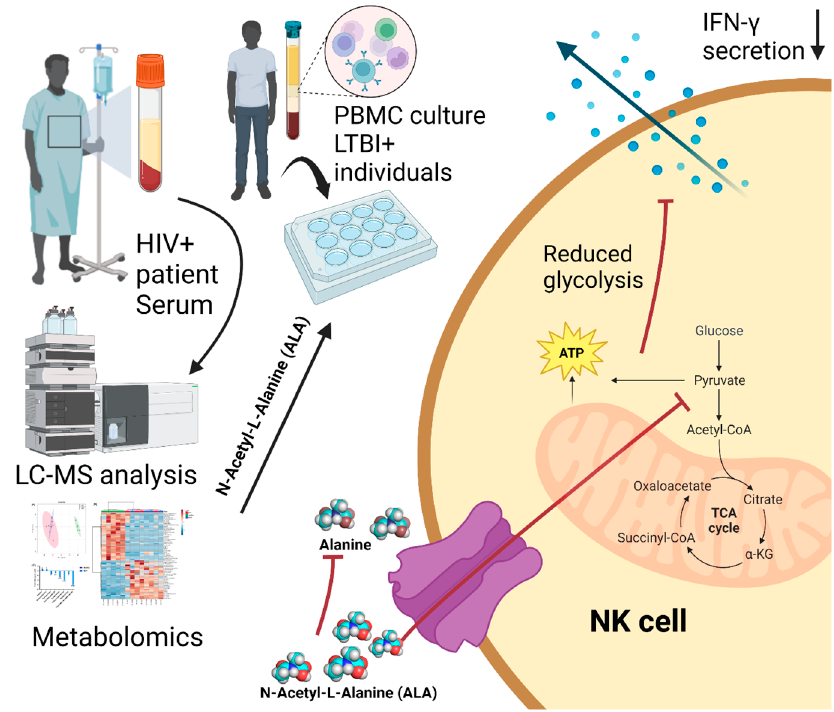
Figure 8. Schematic representation of the potential mechanism of how ALA regulates the immune response of the PBMCs from the LTBI+ individuals. The HIV-differentiated metabolite ALA targets NK cells and functions as a downregulator to reduce NK cell glycolysis, resulting in NK cell autophagy and the reduction in IFN- γ production.